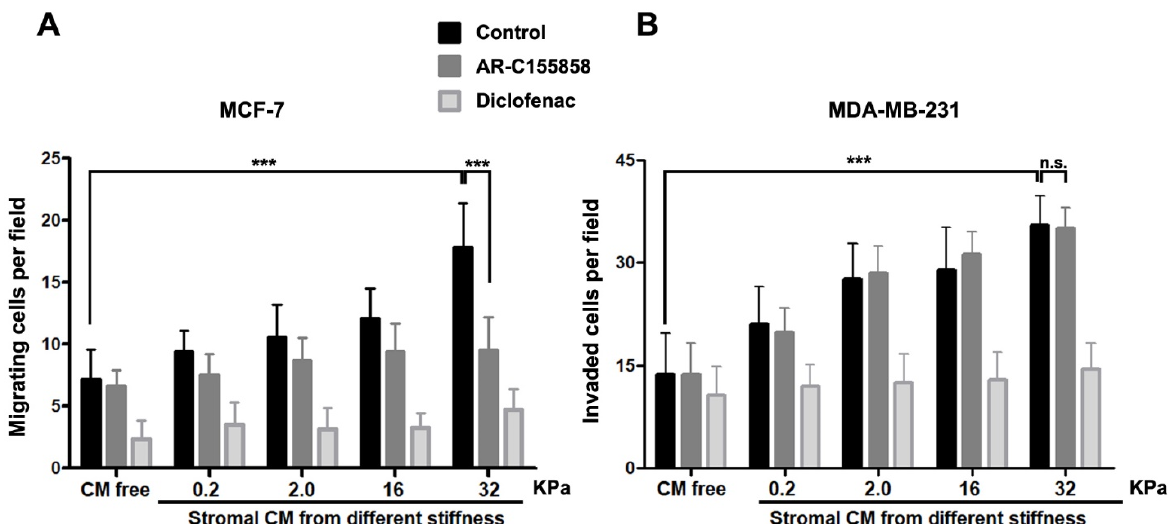
Figure 5. Epithelial migration was stimulated by media conditioned by stromal cells previously plated on increasing stiffness surfaces. The differential role of monocarboxylate transporters. MCF-7 and MDA MB-231 epithelial cells (5 × 10 4 ) were stimulated to migrate in a Transwell system for 24 and 16 h, respectively, under the stimulus of 50% media conditioned by RMF 621 cells previously plated on surfaces with increasing stiffness. To test the role of MCTs in this stimulus, in a group of cells, migration was performed in the presence of 1 µ M of AR–C155858 (which blocks MCT1 and MCT2 but not MCT4) and in another, in the presence of 1 mM of diclofenac (a structurally-unrelated MCT1 and MCT4 blocker). The data are presented as the means ± standard error (SEM). (n.s.) non-significant difference. (***) indicates statistically significant differences, with p ≤ 0.001 using the Kruskal–Wallis test, followed by Dunn’s multiple comparisons test.